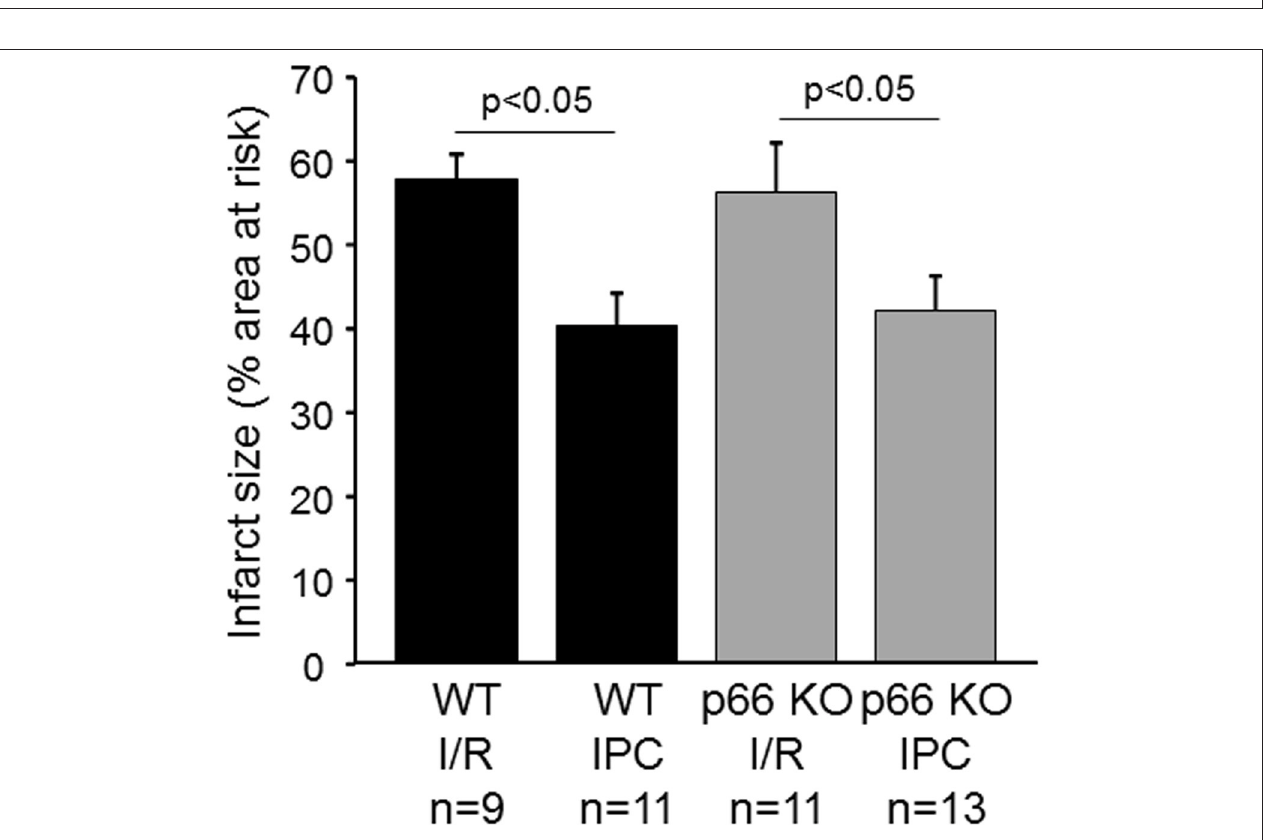
FIGURE 4 | Influence of p66shc on myocardial IR injury and cardioprotection by ischemic preconditioning in vivo . Infarct size (in % of the area at risk) in WT and p66shc knockout (p66 KO) mice subjected to ischemia/reperfusion (IR) or ischemic preconditioning (IPC).